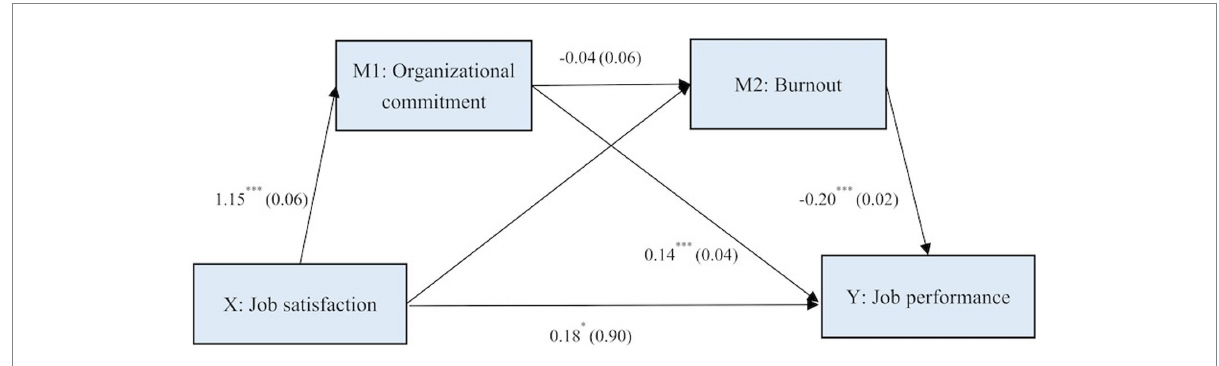
FIGURE 1 Path diagram of job satisfaction and performance mediated by organizational commitment and burnout with non-standardized β and standard errors. * p < 0.05; *** p < 0.001.